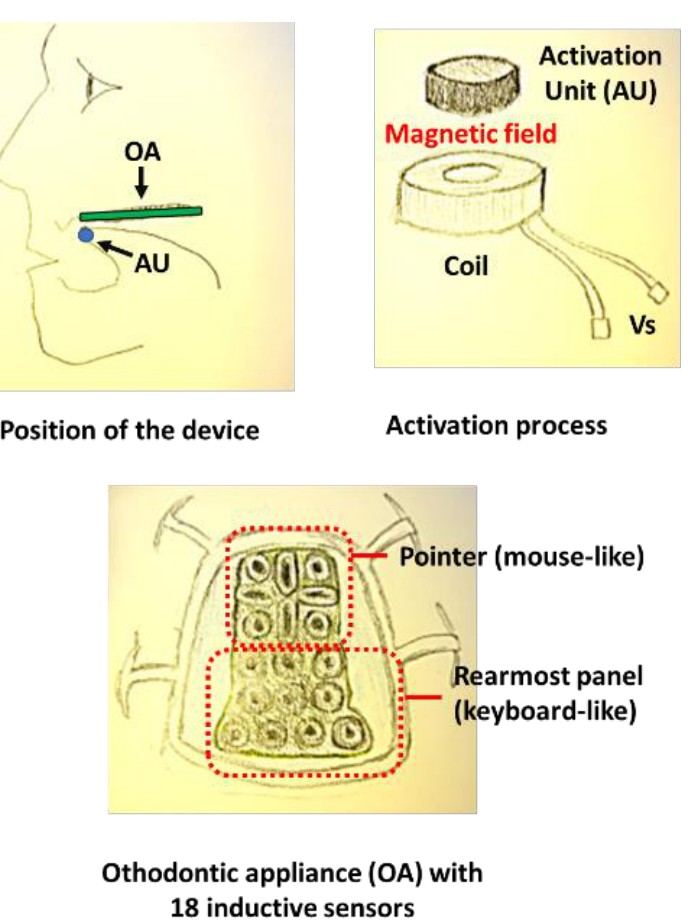
Figure 4. Sketch (realized by D.G.) of the Itongue and its components.